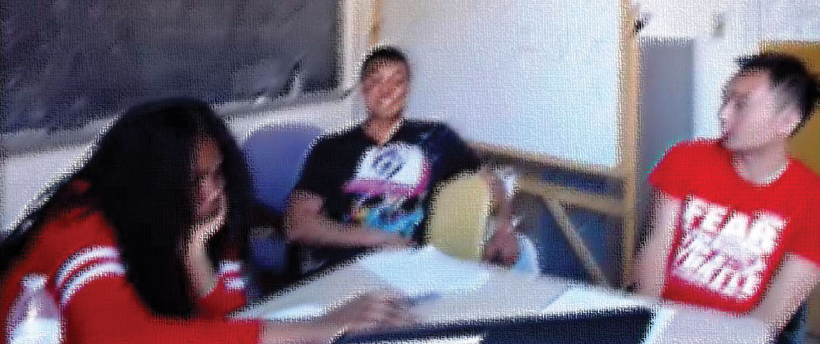
FIG. 2. Zoe is on the left, leaning towards the bottom center of the figure, where the computer is. Devran is in the middle, casually leaning back in his chair. Jonathan, on the right, has also leaned back, as he and Devran predict how the next run of the simulation will compare to the previous